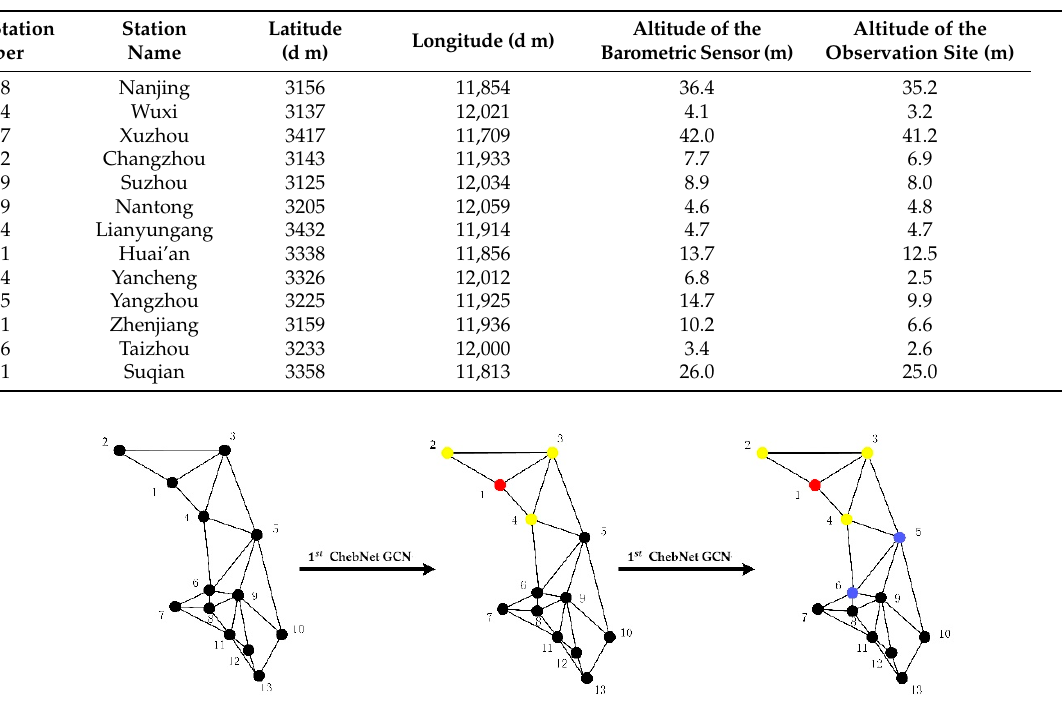
Table 6. Observation data of basic meteorological elements at ground meteorological stations in Jiangsu Province.